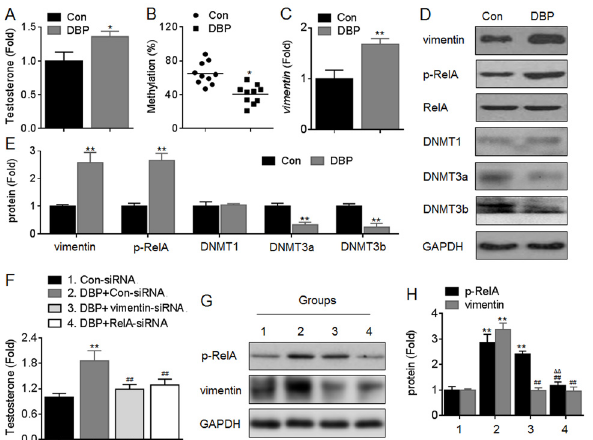
Fig 10. Effects of NF- κ B/vimentin on DBP-induced testosterone secretion in vivo . The pubertal male, Sprague-Dawley rats (10 per guoup) were orally administered DBP at the doses of 1 mg/kg (cid:1) day for 30 days. (A) The serum testosterone level was determined in triplicate. (B) The methylation status of vimentin promoter regions was determined in triplicate by qMSP. (C) qRT-PCR analysis in triplicate of the expression of vimentin mRNA. (D) Western blots analysis and (E) relative protein levels of p-RelA, vimentin, DNMT1, DNMT3a, and DNMT3b. * p < 0.05 and ** p < 0.01 compared with rats exposed to no DBP. (F-H) After Con- siRNA, RelA-siRNA, or vimentin-siRNA was injected into the interstitial tissue of testis, respectively, the rats were orally administered DBP as described above. (F) The serum testosterone level was determined in triplicate. The amounts of testosterone measured in control animals were 16.36 ± 0.22 ng/ml. (G) Western blots analysis and (H) relative protein levels of p-RelA and vimentin. ** p < 0.01 compared with Con-siRNA group; ## p < 0.01 compared with DBP plus Con-siRNA group; ΔΔ p < 0.01 compared with DBP plus vimentin- siRNA